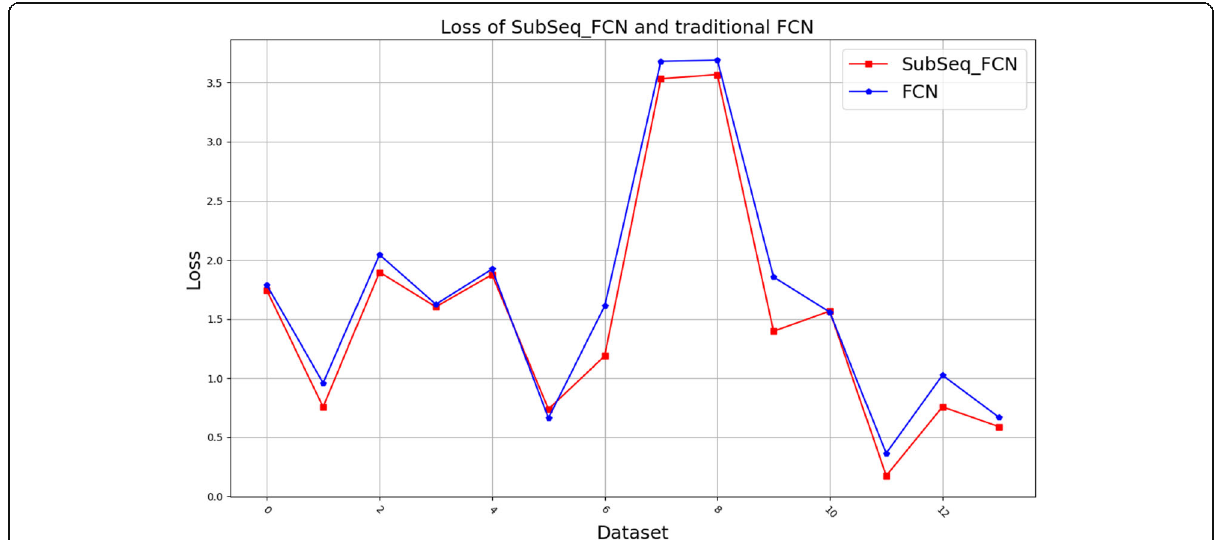
Fig. 10 The loss of original sequence and feature subsequences on FCN